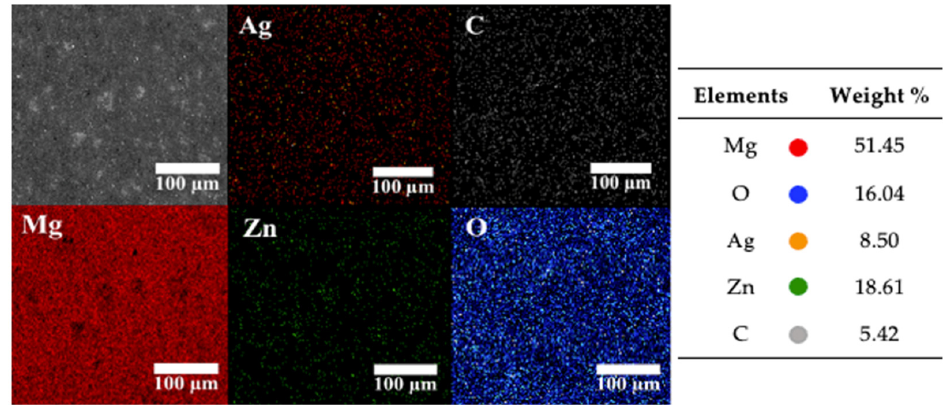
Figure 12. EDS maps (200 × ) of the elements present in the hybrid ZnO/Ag deposits on Mg–Ca0.3 surfaces, electroless achieved from aqueous solutions (10 − 3 M, at 21 °C) Zn(NO 3 ) 2 /AgNO 3 .